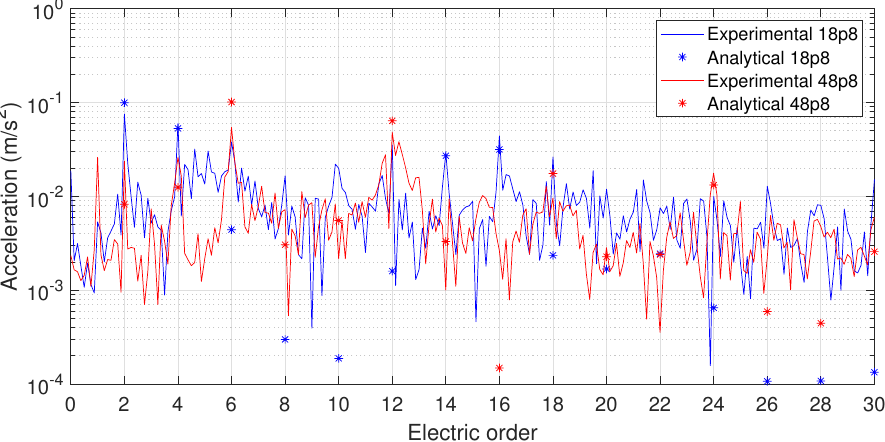
Figure 11. Comparison of the vibration response of the machines of 18 slots and 8 pole pairs, and 48 slots and 8 pole